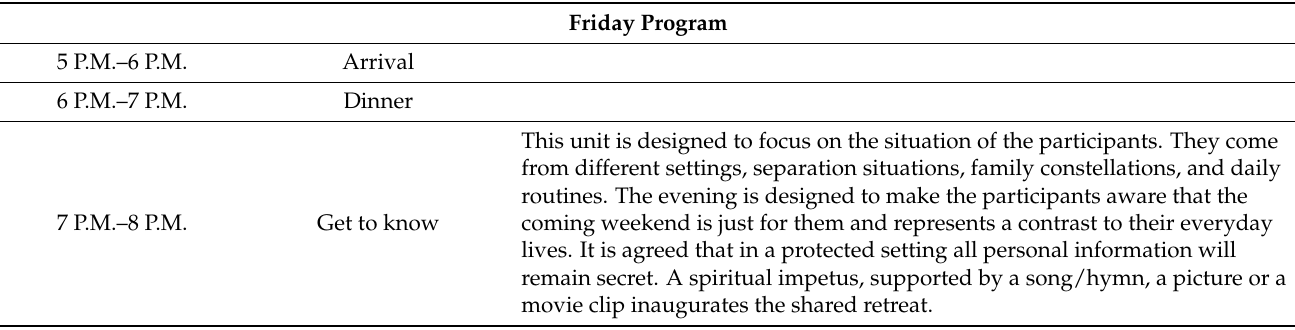
Table A4. Structure of the Exploring New Paths